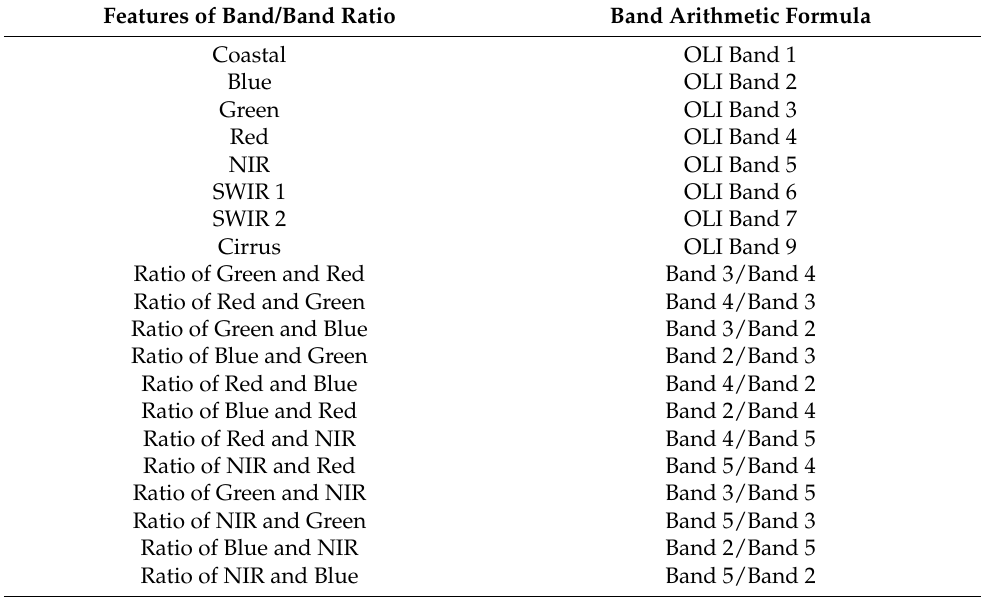
Table 2. Spectral properties of raw bands and band ratios computed from the Landsat 8 OLI